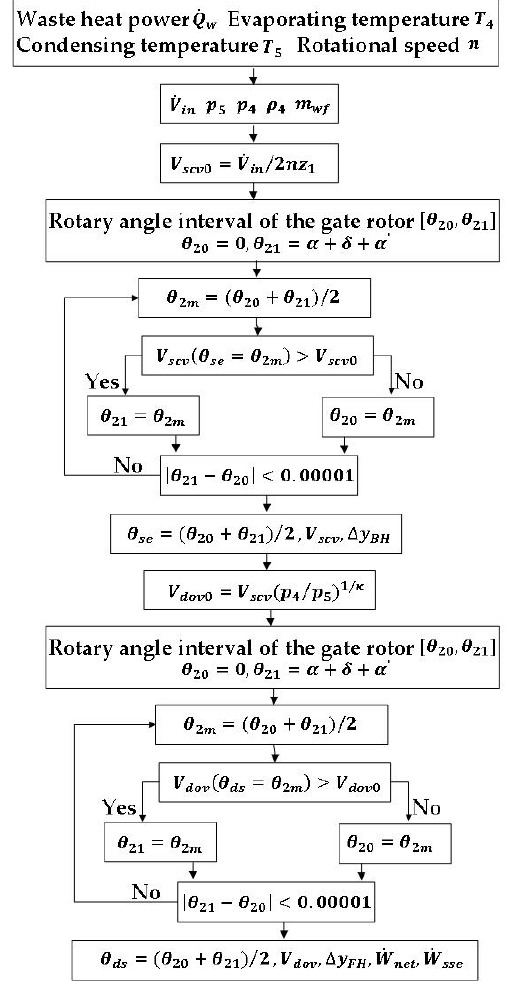
Figure 12. Flow chart of the calculation.